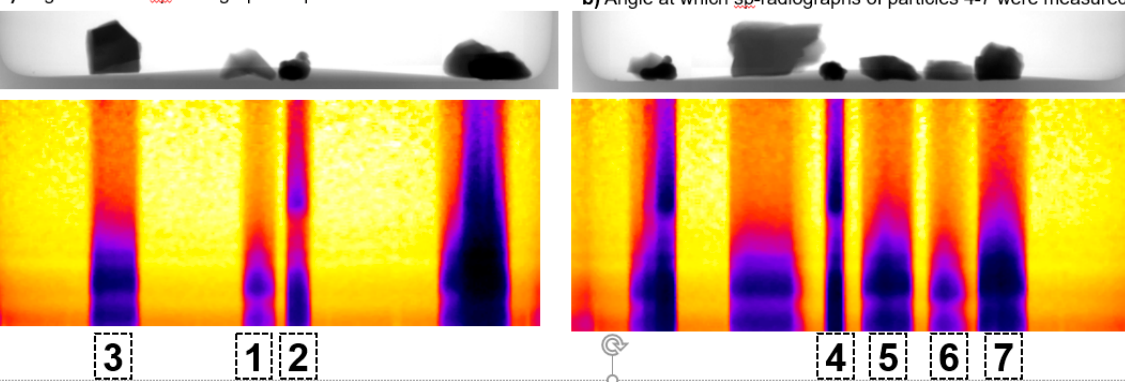
Figure A1. Radiographs at angles where the marked particles are not aligned between source and detector ( a ) particles 1–3 and ( b ) particles 4–7. At these positions, the attenuation spectra of the marked particles are independent from the other particles. These positions were used to derive the spectra in Figure 3c.